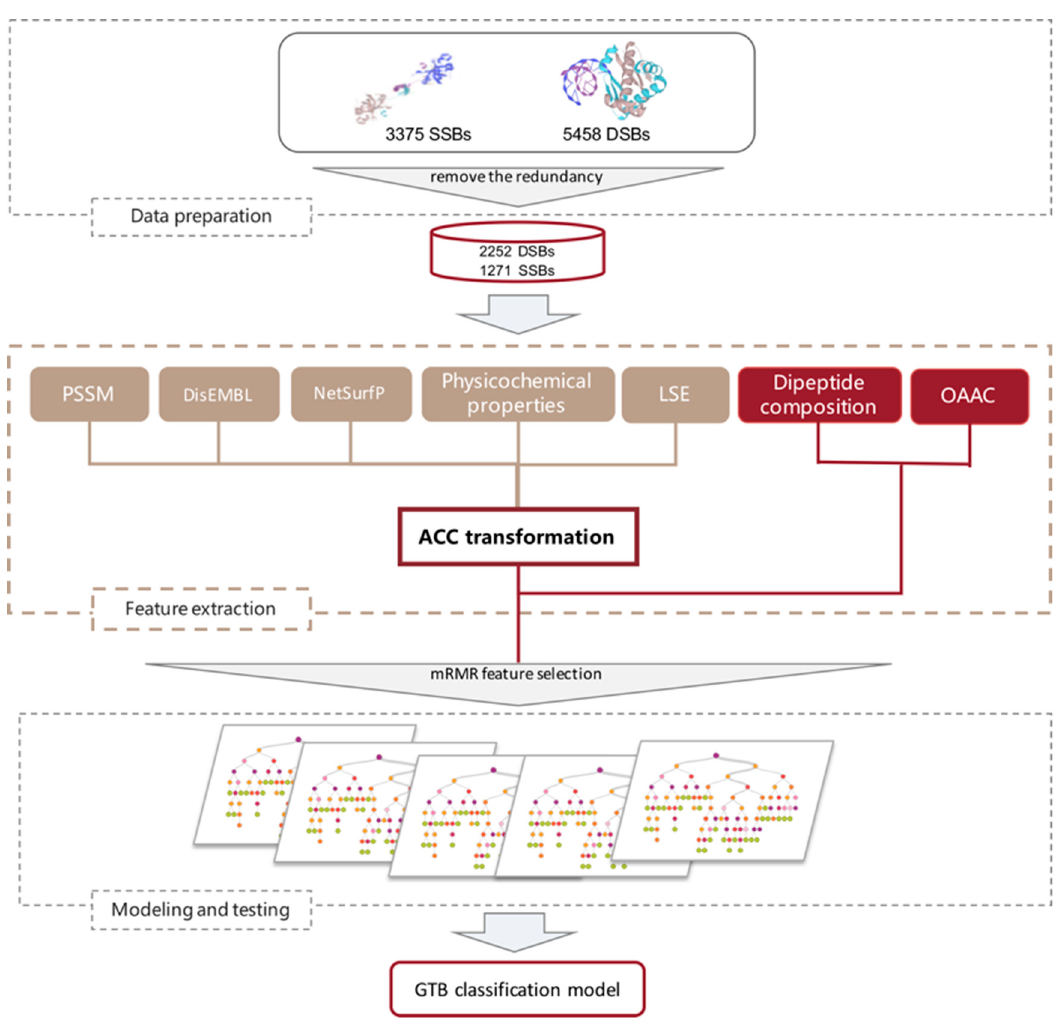
Figure 1. Workflow of PredPSD